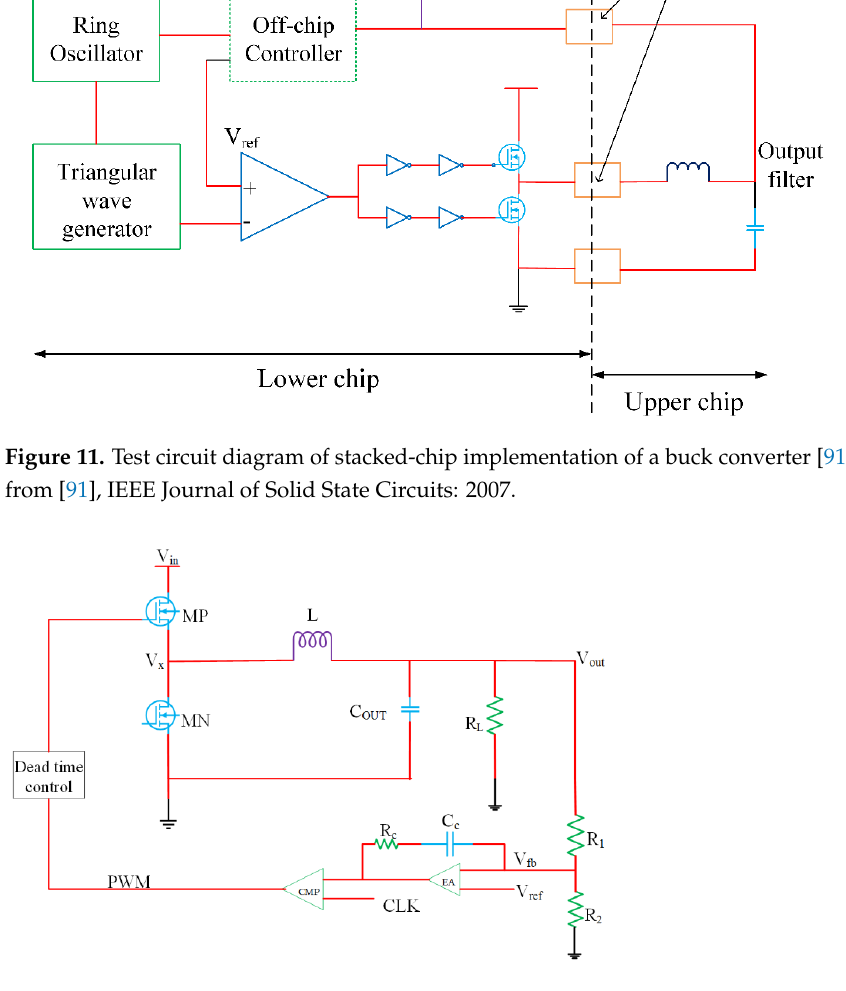
Figure 11. Synchronous buck converter and its control [84]. Reproduced from [84], In Proceedings of the IEEE European Solid-State Circuits Conference: 2009. Figure 12. Circuit diagram of multistage interleaved synchronous DC–DC buck converters [87]. Reproduced from [87], IEEE Transactions on Power Electronics: 2007.